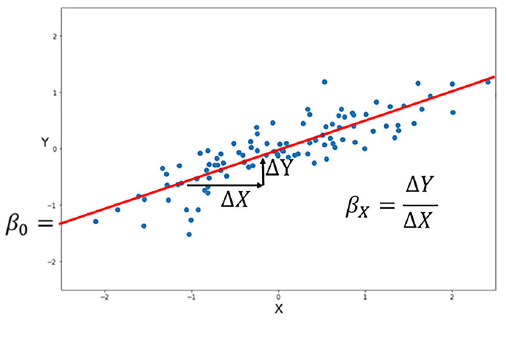
which can be conceptually represented as a path model, shown in Figure 2.